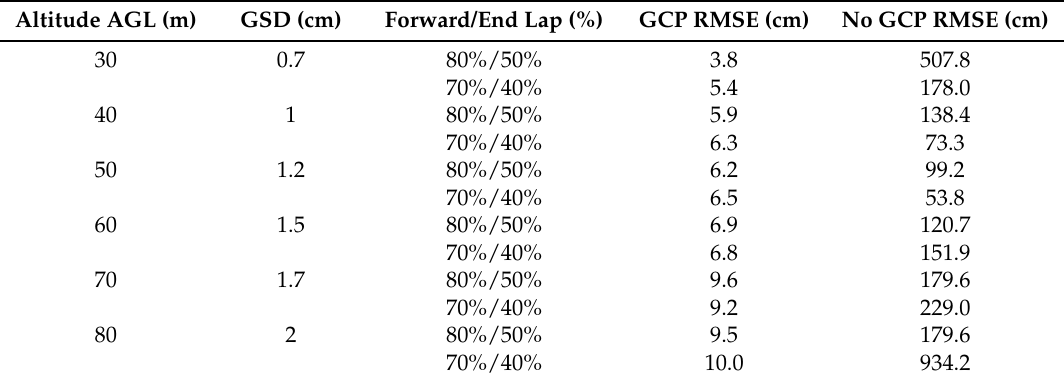
Table 3. Absolute positional accuracy results factoring altitude AGL, percentage of forward and side overlap and processing with or without GCPs. Altitude AGL (m) GSD (cm) Forward/End Lap (%) GCP RMSE